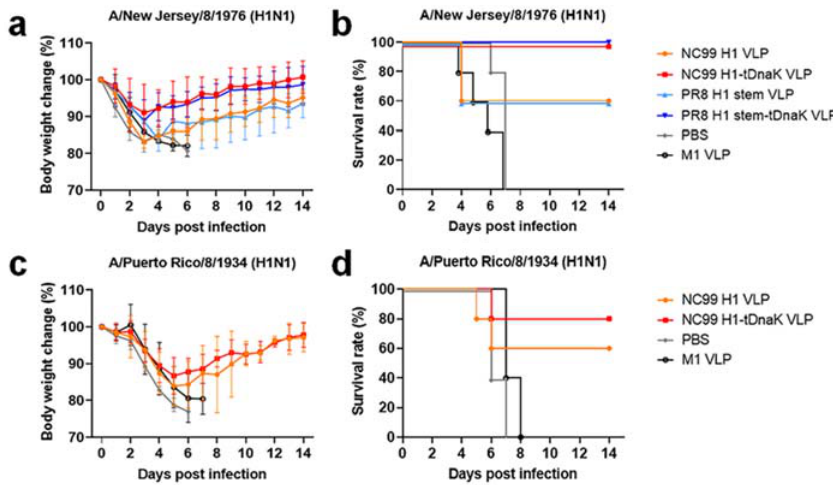
Figure 6. VLP protective efficacy in BALB/c mice. Body weight changes ( a , c ) and survival rates ( b , d ) of the immunized mice ( n = 5 per group) upon challenges with 3 × LD 50 lethal dose infections with NJ76 ( a , b ) or PR8 H1N1 ( c , d ).